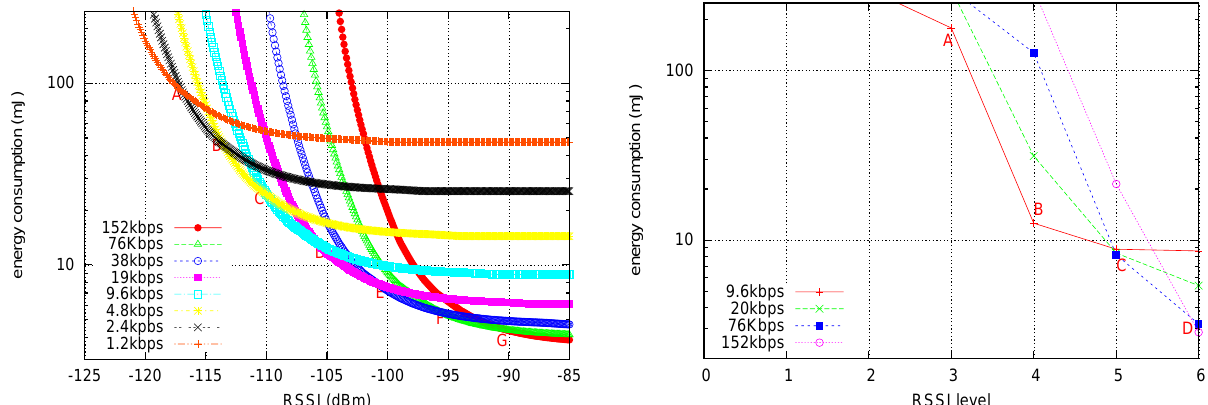
Figure 1 . Network energy consumption vs. RSSI values at different data rates. (Note the Y-axis log